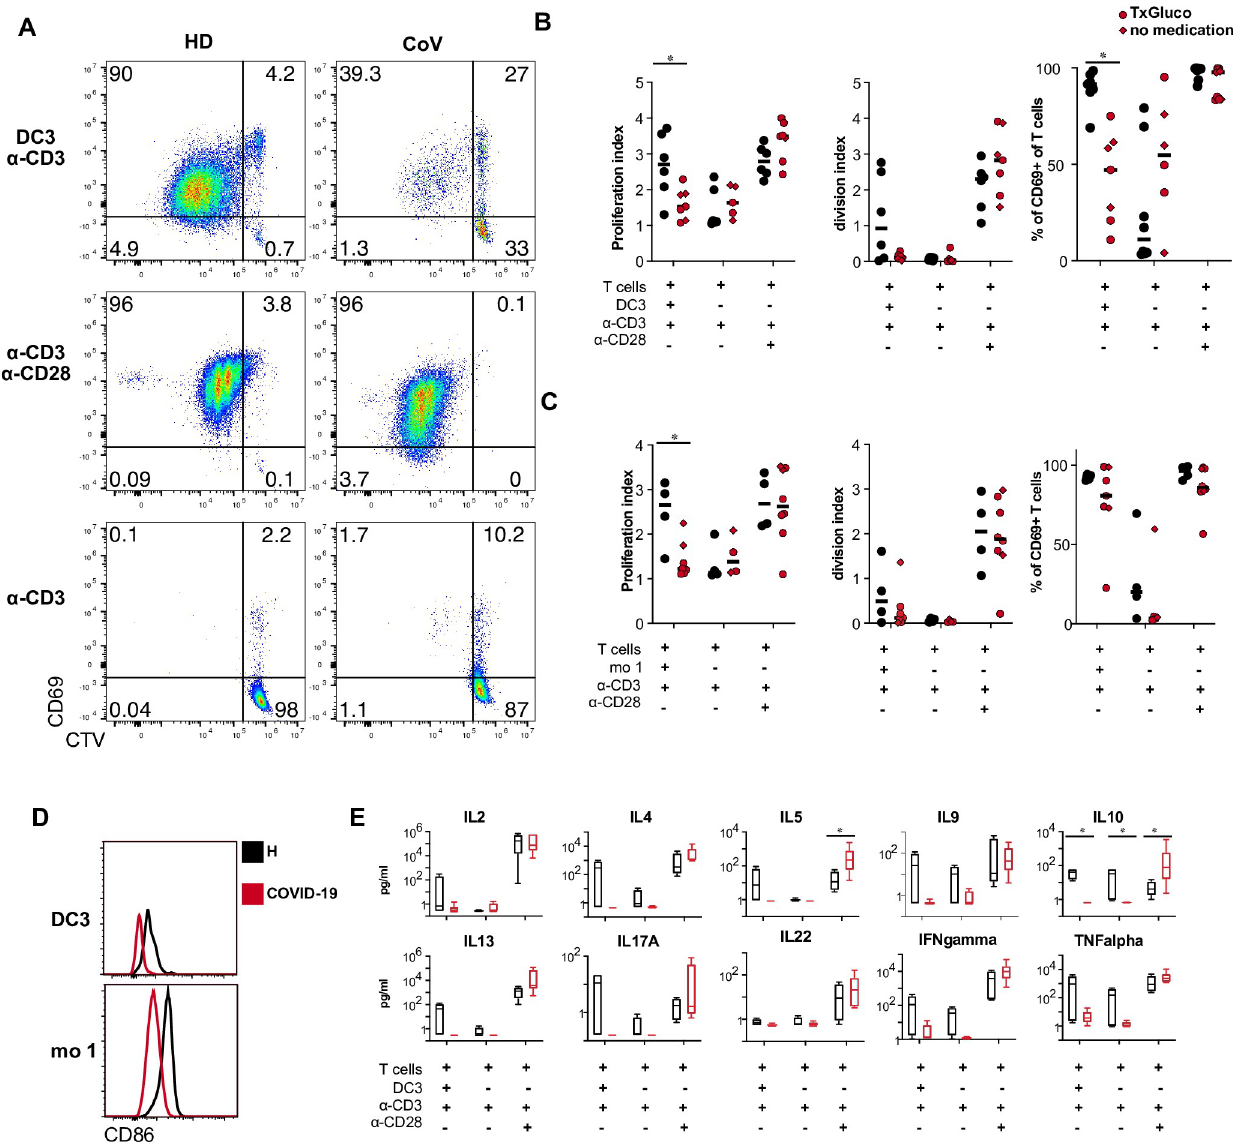
Fig 6. DC3 and monocytes from COVID-19 patients have reduced ability to stimulate na ï ve CD4 T cells. (A-D) CTV-labeled autologous na ï ve CD4 + T cells were stimulated with immobilized anti-CD3 antibodies in the presence or absence of DC3 and mo 1 sorted from PBMC of healthy donors and COVID-19 patients at a 1:2 ratio for 5 days. Stimulation with anti-CD3/CD28-coated beads was used as a positive control. (A) Representative dot plots showing proliferation of CD4 + T cells by CTV dilution and activation by CD69 expression (HD healthy donor, CoV COVID-19 patient). (B) Proliferation index, division index and percentage of CD69 + T cells are shown for cocultures with DC3 from healthy controls (black symbols n = 6) and COVID-19 patients (red symbols, n = 7, circles: glucocorticoid therapy, diamonds: no glucocorticoid therapy). (C) Proliferation index, division index and percentage of CD69 + T cells are shown for cocultures with monocytes (H, n = 4; CoV, n = 4–7). (D) Representative histogram overlay showing CD86 expression in DC3 and mo 1 sorted from a COVID-19 patient and a healthy donor used for coculture. (E) Cytokines were measured in the supernatants of DC3/T cell cocultures (H, n = 4; CoV, n = 6). (B, D) � p < 0.05, Mann-Whitney